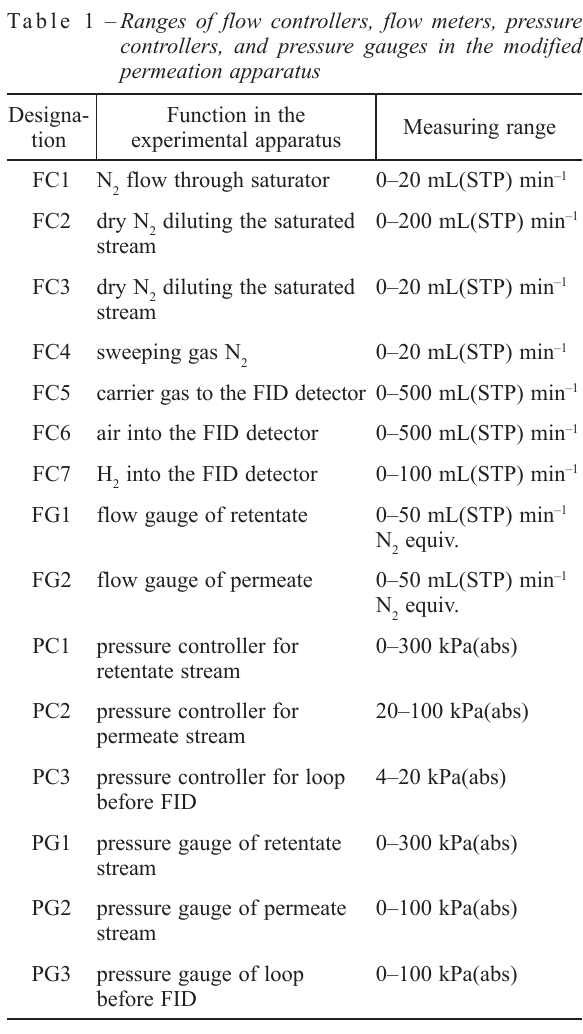
Table 1 – Ranges of flow controllers, flow meters, pressure controllers, and pressure gauges in the modified permeation apparatus